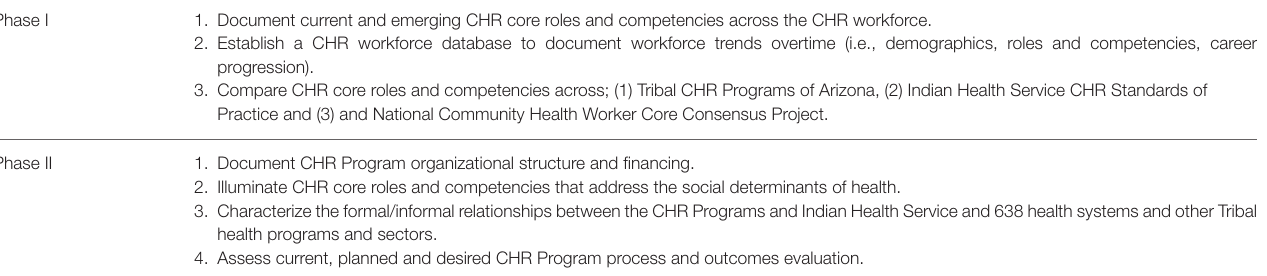
TABLE 1 | Arizona CHR workforce assessment